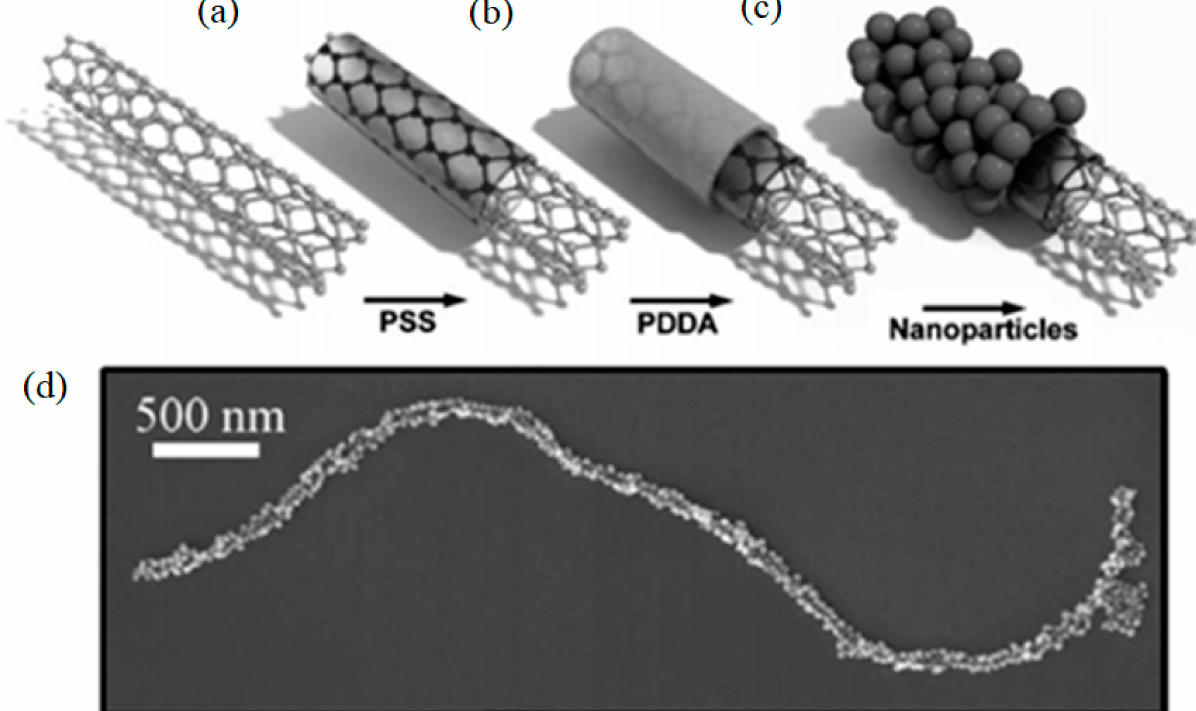
Figure 9. Diagrams illustrating a non-covalent CNT functionality consisting of ( a ) polymers wrapping by poly(4-styrene sodium sulfonate) (PSS), ( b ) poly(diallyldimethylammone chloride) (PDDA) self-assembly, ( c ) nanoparticle deposition and ( d ) SEM (top) image of one Au@SiO 2 -nano-particles monolayer, assembled in the reference carbon nanoparticles, RSC, 2006